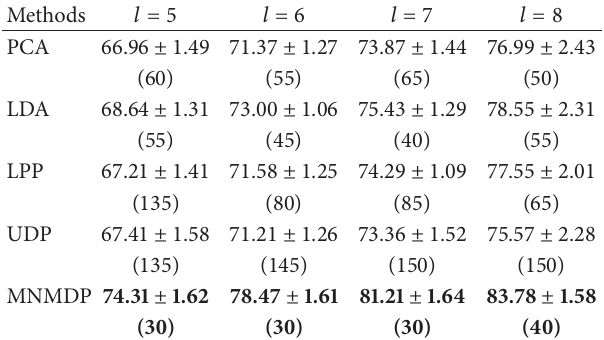
Table 1: The maximal average recognition rates (%) of each method on HRF with the corresponding standard deviations (stds) and values of dimension in the